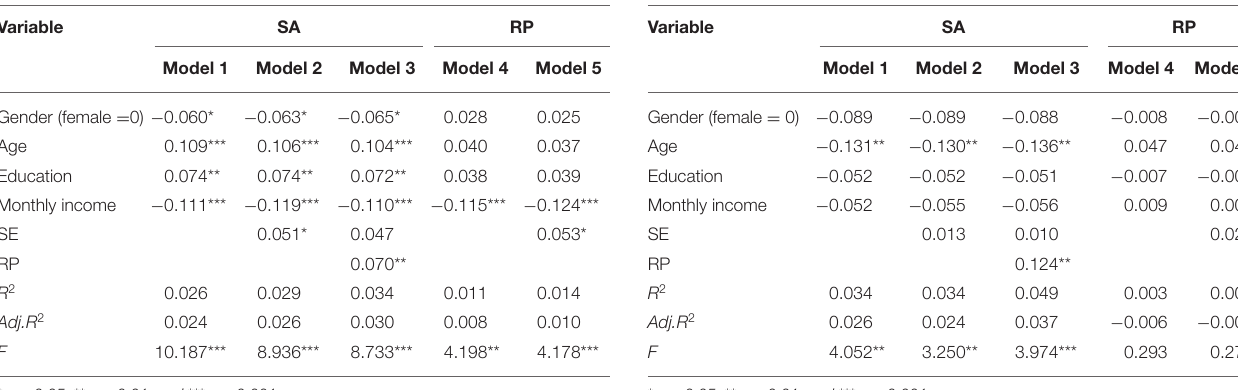
TABLE 4 | Regression test of the mediating effect during pandemic ( N = 1511).